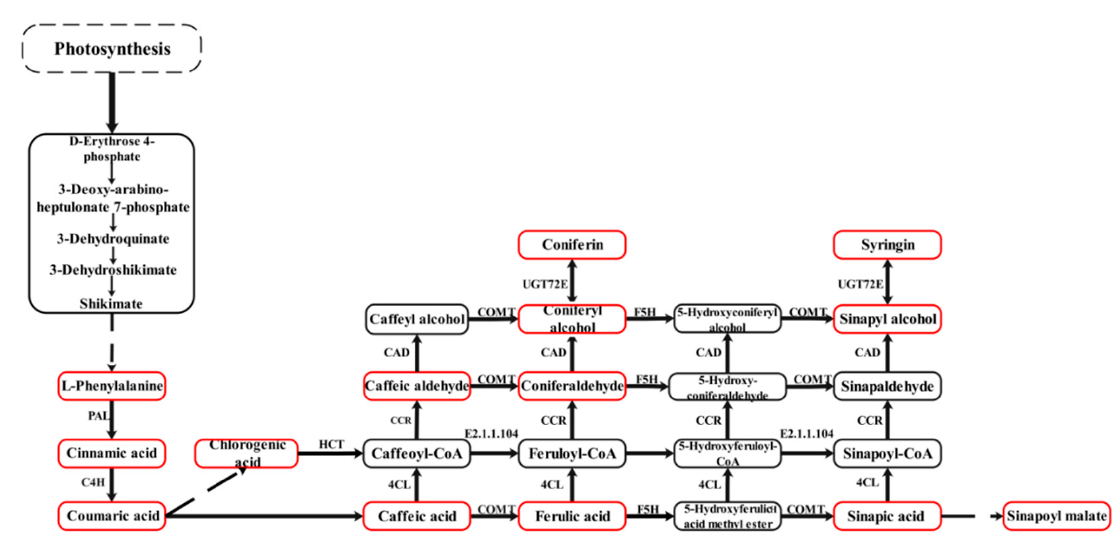
Figure 1. The phenolic acid synthesis pathway of Cyclocarya paliurus leaves. The red squares indicate detected metabolites and the dashed lines indicate a series of enzymatic reactions. PAL, phenylalanine ammonia-lyase; C4H, trans-cinnamate 4-monooxygenase; F5H, ferulate-5-hydroxylase; COMT, ca ff eic